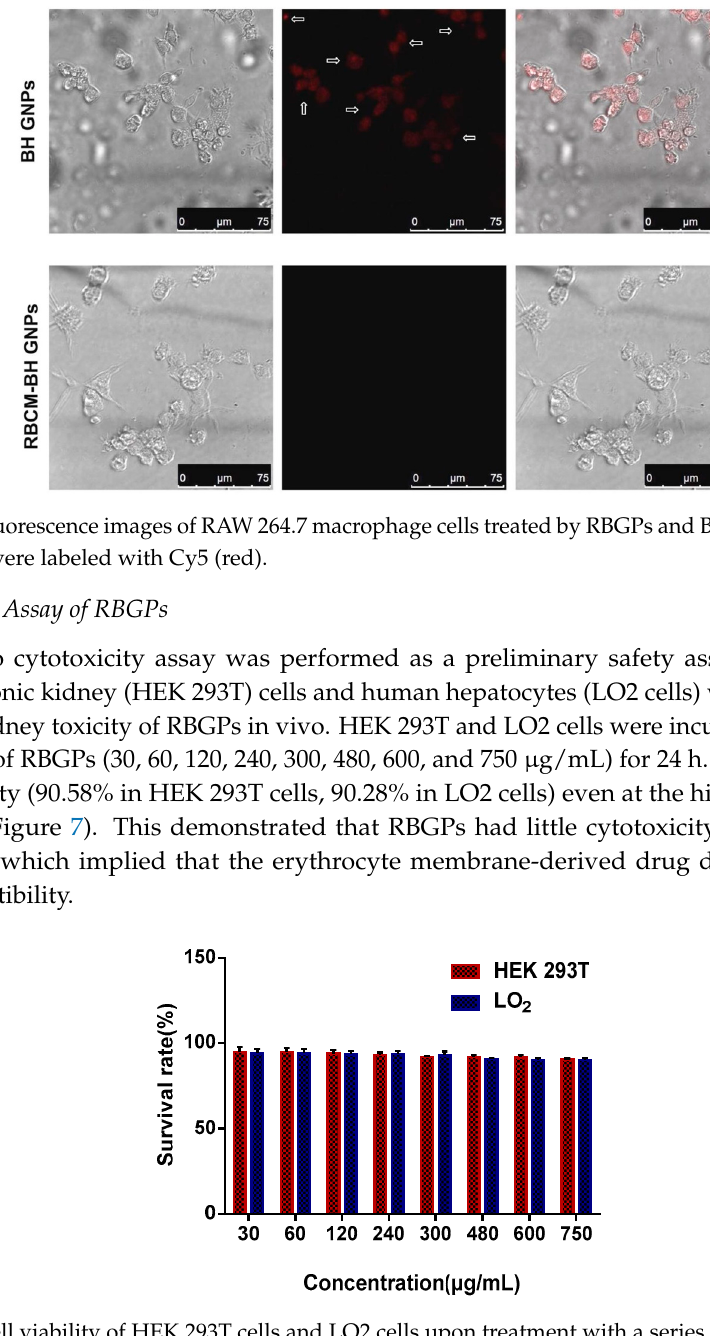
Figure 7. Cell viability of HEK 293T cells and LO2 cells upon treatment with a series of concentrations of RBGPs (3, 60, 120, 240, 300, 480, 600, 750 μ g/mL).